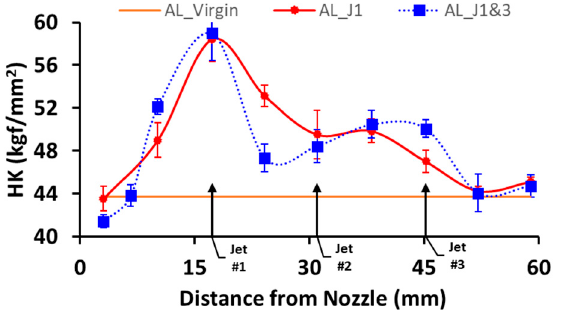
Figure 14. Hardness distribution on the specimen with Jet #1 and with a combination of Jet #1 and Jet #3.